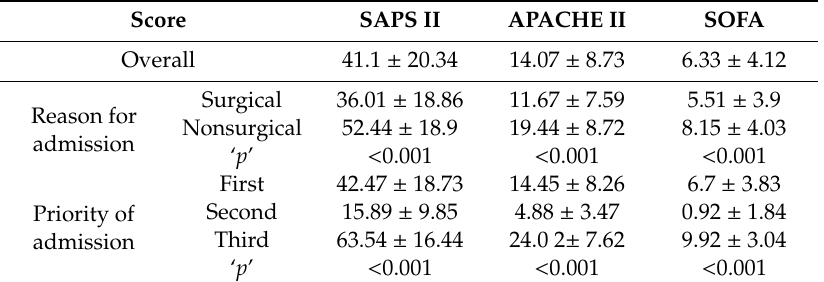
Table 1. Simplified Acute Physiology Score (SAPS) II, Acute Physiology and Chronic Health Evaluation (APACHE) II, and Sequential Organ Failure Assessment (SOFA)